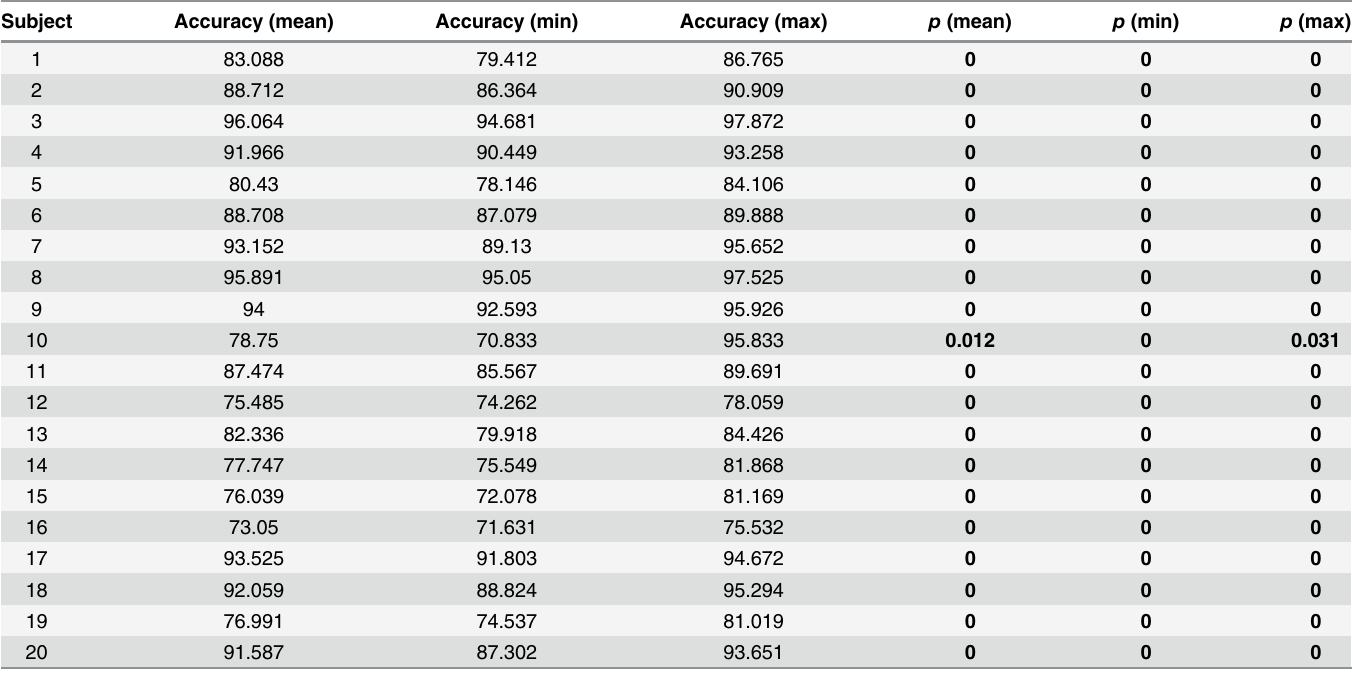
Table 1. Results Flanker Task